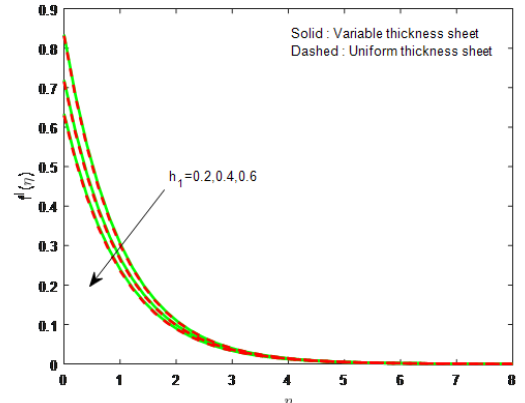
Fig. 14: Influence of h 1 on velocity field